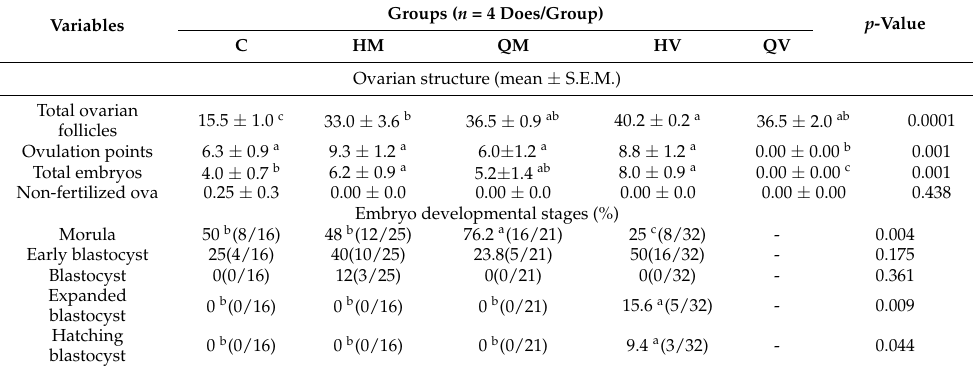
Table 2. Ovarian structure and developmental stages of embryos collected 48 h post-insemination from rabbit does that received two intramuscular doses (HM = 0.4 µ g and QM = 0.2 µ g) or two intravaginal doses (HV = 4 µ g and QV = 2 µ g) of GnRH–ChNPs compared to control rabbit does that received bare GnRH (0.8 µ